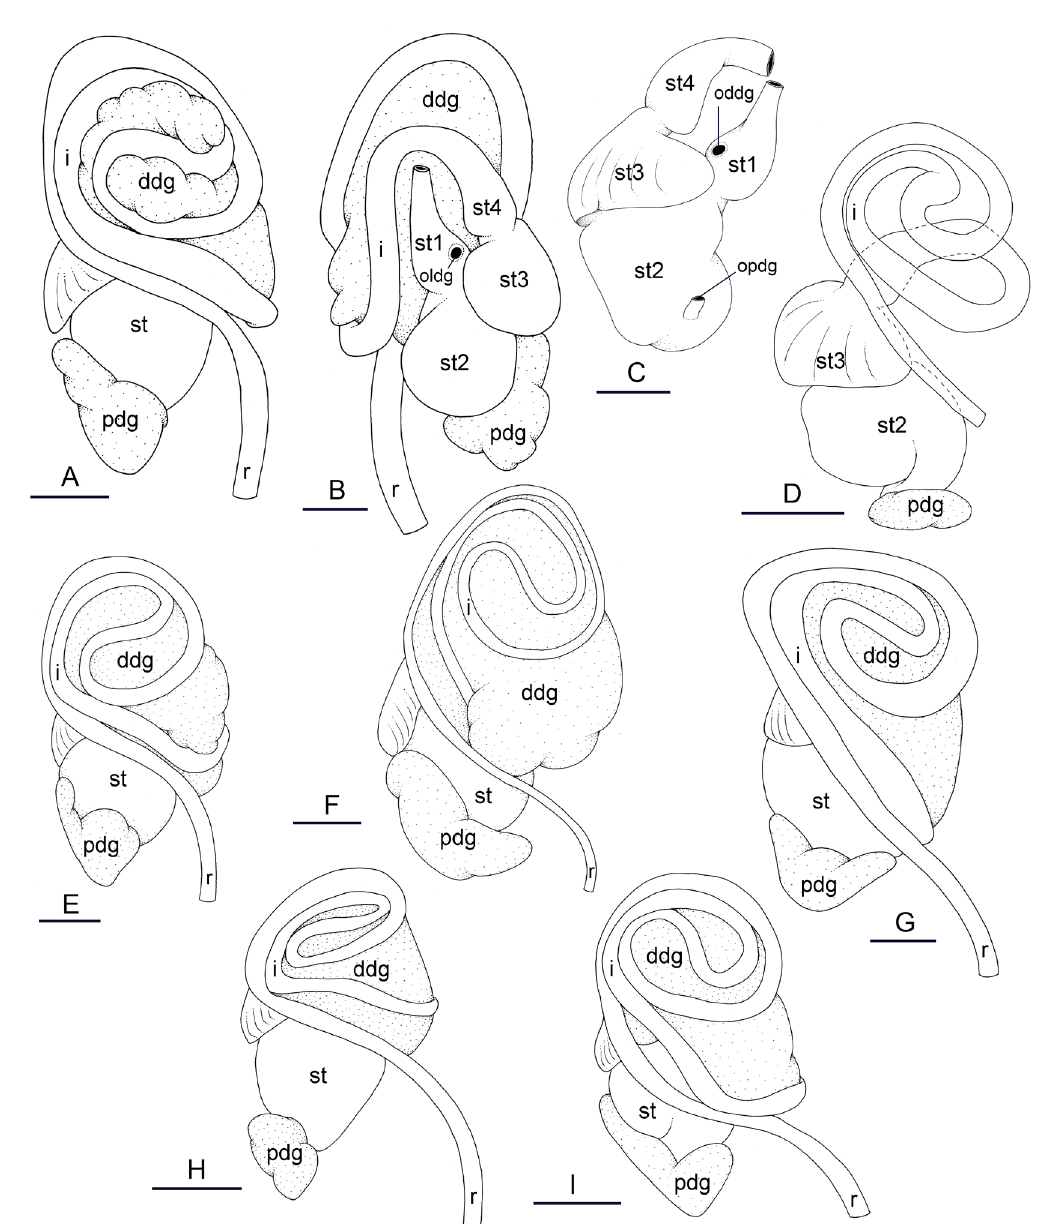
Fig. 12. Paromoionchis tumidus (Semper, 1880) comb. nov., digestive system. A . Unit #1, dorsal view, Indonesia, Sulawesi [2240] (UMIZ 00125). B . Ventral view (lateral digestive gland removed), same as A. C . Stomach, dorsal view, same as A. D . Dorsal view (digestive gland removed prior to present study, intestinal loops loose), holotype of Onchidium honkongense Britton, 1984 (NHM 1982290). E . Unit #2, dorsal view, Australia, Northern Territory [1638] (NTM P.57623). F . Unit #3, dorsal view, Papua New Guinea, Madang [5433] (MNHN IM-2013-10479). G . Dorsal view, lectotype of Onchidium mertoni Simroth, 1918 (ZMB 121591a). H . Dorsal view, lectotype of Onchidium tumidum (ZMB 39019a). I . Dorsal view, lectotype of Onchidium samarense Semper, 1880 (ZMB 39025a). Abbreviations: ddg = dorsal lobe of digestive gland; i = intestine; oddg = opening of dorsal lobe of digestive gland; oldg = opening of lateral lobe of digestive gland; opdg = opening of posterior lobe of digestive gland; pdg = posterior lobe of digestive gland; r = rectum; st = stomach; st1 = stomach chamber 1; st2 = stomach chamber 2; st3 = stomach chamber 3; st4 = stomach chamber 4. Scales: A–C, F = 2 mm; D, I = 3 mm; E = 5 mm; G = 1 mm; H = 4